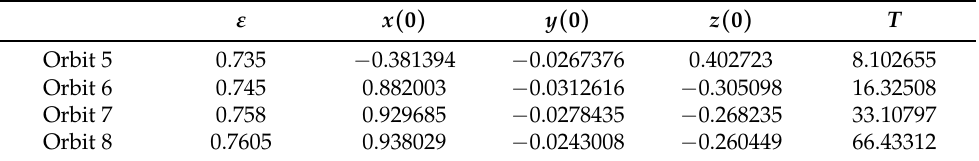
Table 2. Initial conditions and periods for ε = 0.735,0.745,0.758 and 0.7605.